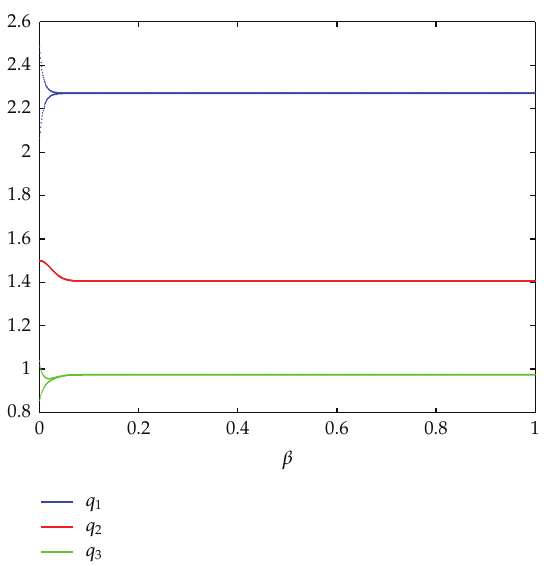
Figure 6: Bifurcation diagram with respect to β for α (cid:7) 18 .